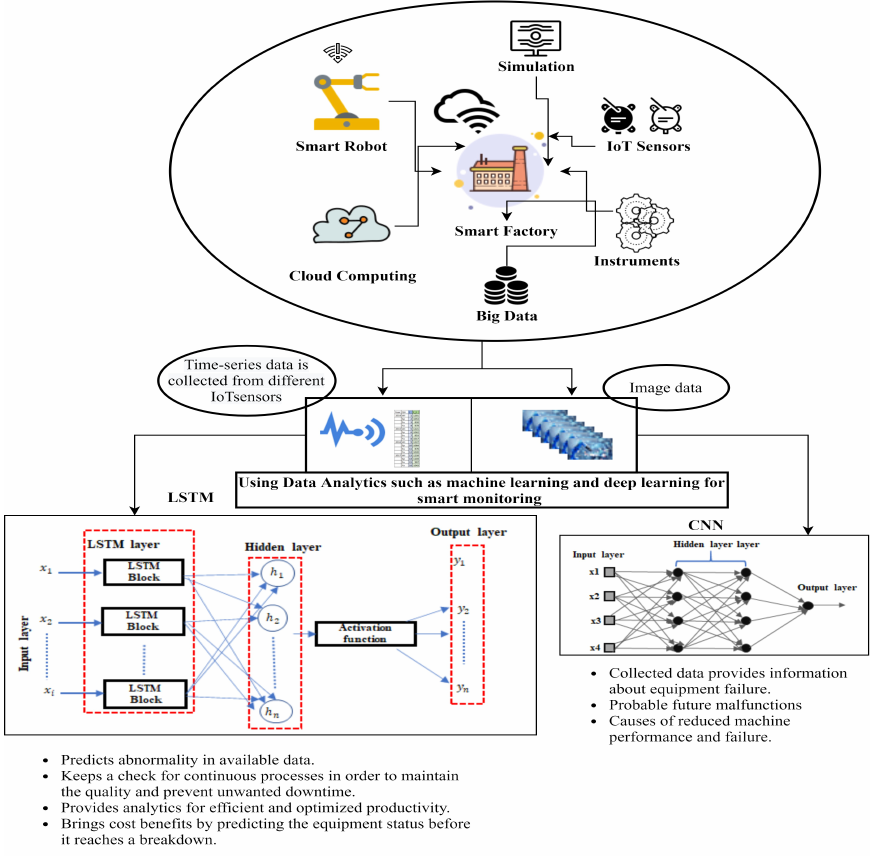
Figure 1. A connected smart manufacturing production line for Industry 4.0. The data collected from IoT sensors are efficiently used with AI innovations, better productivity, and technology dissemination. Deep learning algorithms such as LSTMs are used for time-series forecasting, and CNNs are used for processing image-based data for predictive maintenance. The overall goal of the framework is to have more information processed over the Internet of Things.